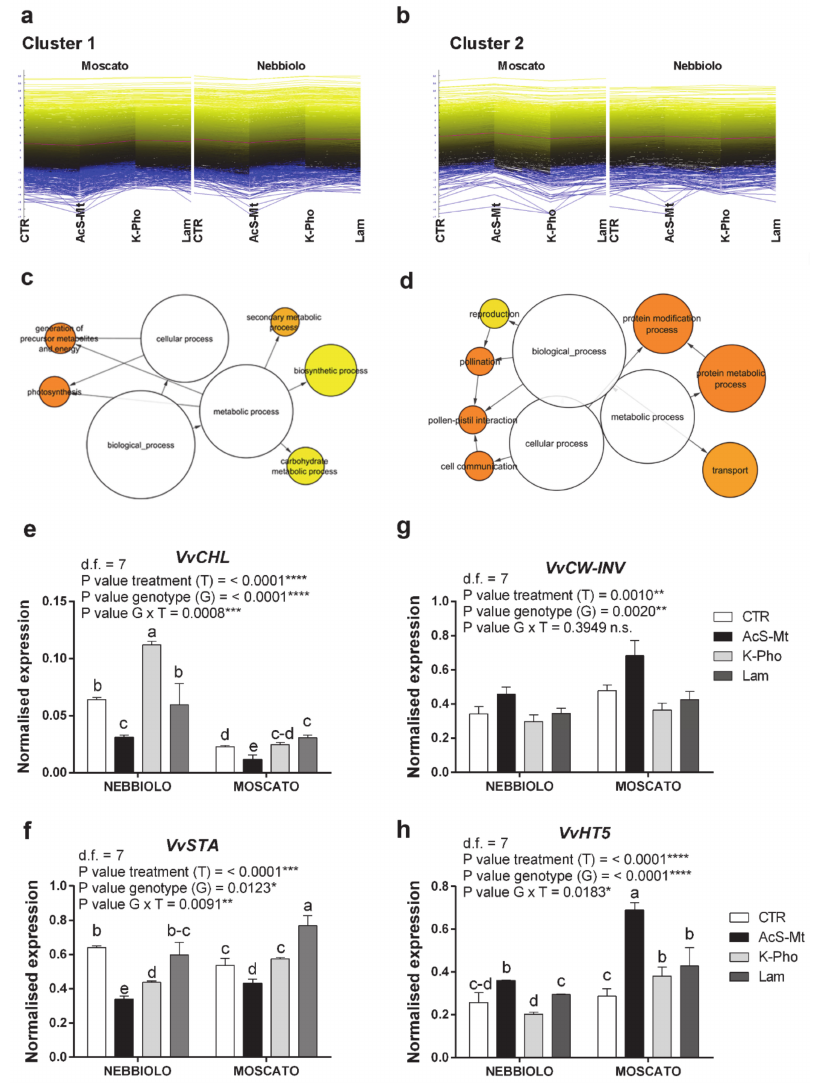
Figure 2. Treatment effect on transcriptional reprogramming of defense responses. ( a , b ) Output of HCL (Hierarchical Clustering) analysis conducted on RNAseq data. Clusters of differentially expressed genes (DEGs) showing a down-regulation ( a , cluster 1) or up-regulation ( b , cluster 2) transcriptional pattern in association with acibenzolar-S-methyl application (AcS-Mt) in ‘Moscato’ and ‘Nebbiolo’ leaf transcriptomes. ( c , d ) Significant enriched GO biological functional categories identified for each group of genes belonging to ( c ) cluster 1 and ( d ) cluster 2 using Cytoscape with the BINGO plug-in and listed according to their enrichment p -value ( p < 0.05). ( e – h ) Results of candidate gene expression analysis performed by RT-qPCR assay. Expression profiles of key genes belonging to cluster 1 ( e - VvCHL , VIT_07s0151g00110; f- VvSTA , VIT_02s0025g02790) and cluster 2 ( g - VvCW-INV , VIT_09s0002g02320; h - VvHT5 , VIT_05s0020g03140) analyzed in leaf samples taken from ‘Nebbiolo’ and ‘Moscato’ plants artificially inoculated with Erysiphe necator and then untreated (CTR) or treated with acibenzolar-S-methyl (AcS-Mt), potassium phosphonate (K-Pho), andlaminarin(Lam). Ubiquitin( VvUBI )andActin( VvACT1 )geneswerebothusedasendogenous controls for the normalization of transcript levels. Significance of genotype, treatment, and genotype × treatment (G × T) interaction was assessed by Tukey’s HSD test for p ≤ 0.05 (*), p ≤ 0.01 (**), p ≤ 0.001 (***), and p ≤ 0.0001 (****) and the corresponding results are given above each graph in the figure panel; n.s. = not significant. Lower case letters above bars are reported when the G × T interaction and / or genotype (G) main effects are statistically significant as attested by Tukey’s HSD or Student’s t -test, respectively. Error bars represent SE. Three independent biological replicates with three technical replicates each were used for the